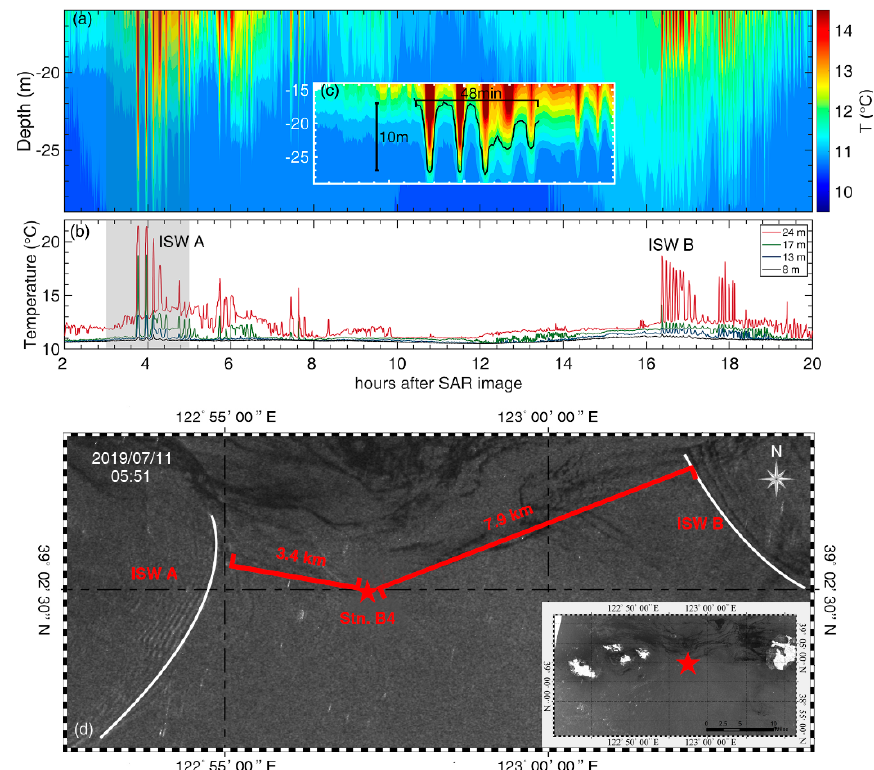
Figure 5. ( a ) Time–depth variations of temperature from 11 July 2019 at 7:51 to 12 July 2019 at 3:51 (UTC + 8). ( b ) The corresponding temporal variations of temperature. ( c ) Inset of the shaded area in ( a ) showing the typical ISWs marked with a black line. ( d ) SAR image was acquired over the northern YS on 11 July 2019 (05:51 UTC + 8). Red stars denote mooring stations. Notably, the x -axis has been changed to hours after this SAR image time.